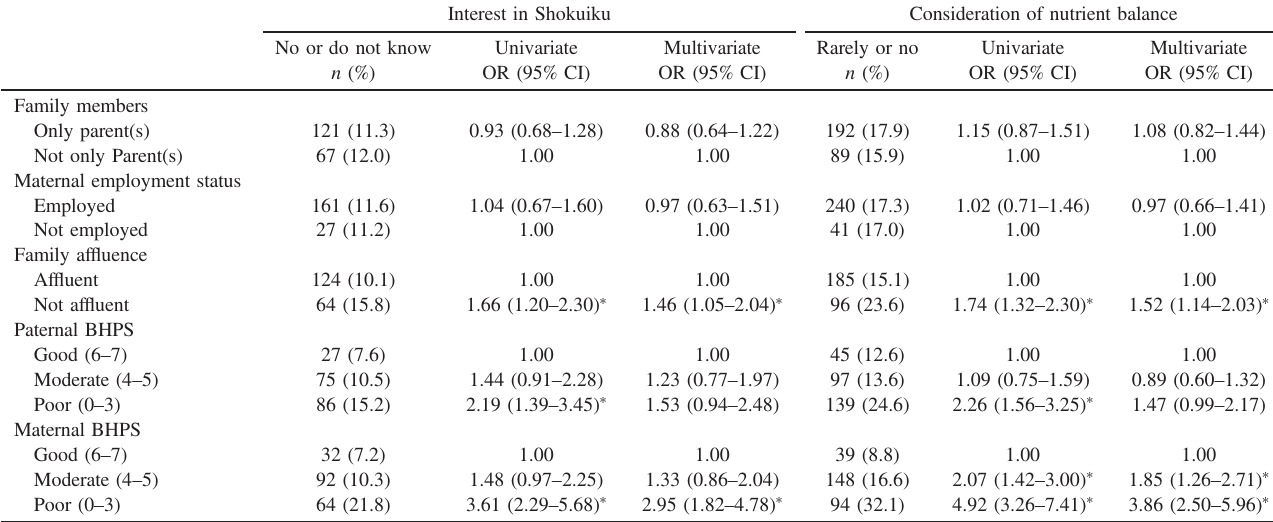
Table 2. The relationship between parental lifestyle factors and dietary